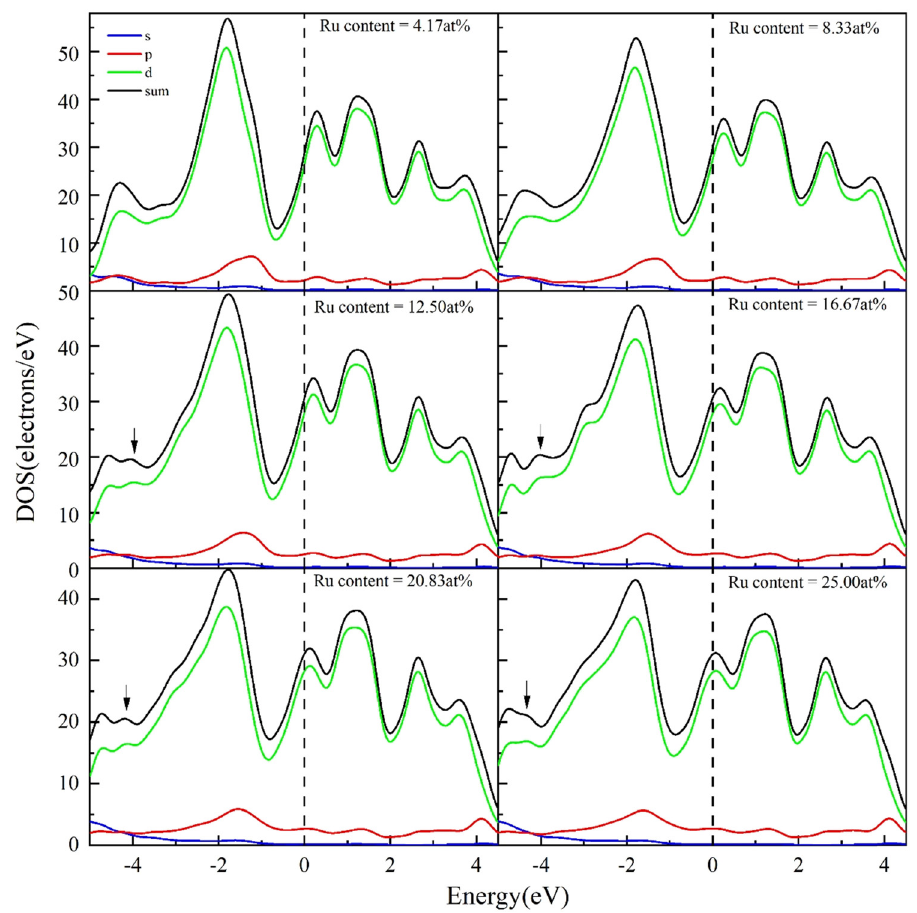
Figure 3: DOS of Ta 8 Cr 16 − n Ru n ( x = 1 – 6 ) alloys.